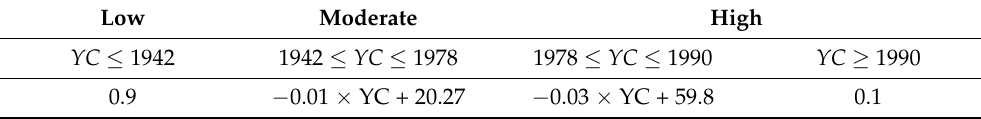
Table 1. Construction year transformation based on the seismic design codes in Albania (compiled by authors based on De Iuliis & Tesfamariam